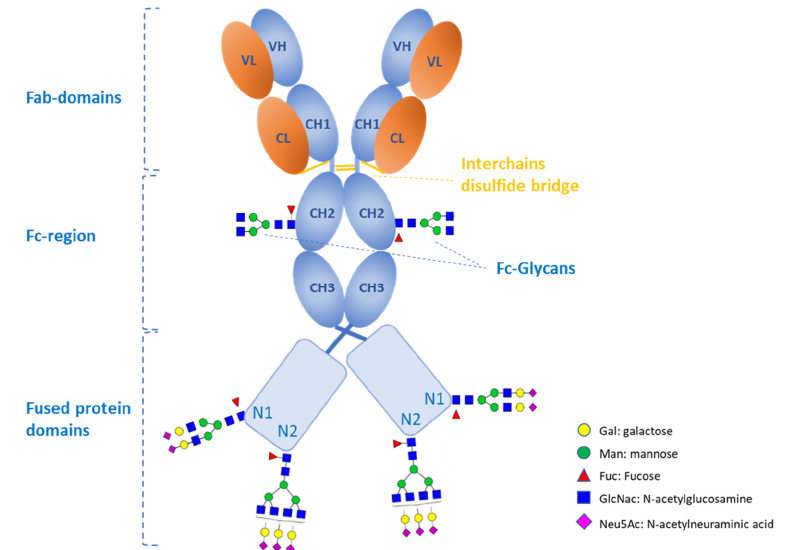
Figure 2. An example of an IgG1 antibody fusion molecule containing 3 N-linked glycans in each heavy chain: one in the CH2 domain of the Fc region and two (N1 and N2) in the fused protein domain. Each site is characterized by its own glycosylation profile. Abbreviations used: VL and CL—variable and constant domains, respectively, of the light chain; VH and CH—variable and constant domains, respectively, of the heavy chain; CH1, CH2, and CH3—constant domains 1, 2, and 3, respectively, of the heavy chain.